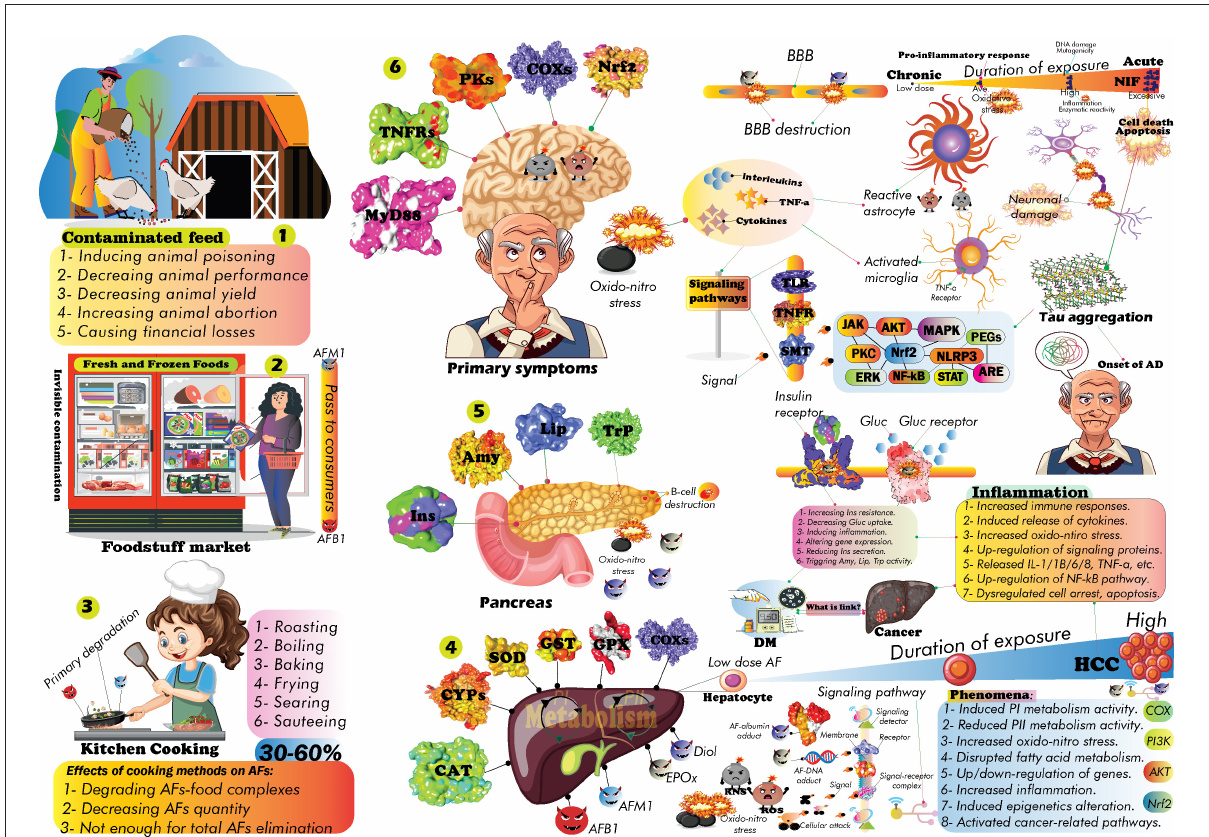
FIGURE10 The cross-links between exposure to AFs and the progression of nCDs. Contaminated feed caused damages to animal farms and produced products will pass to the consumers (Steps 1–2). Food processing methods can effectively be used to eliminate nearly 30–60% of total AFs based on the cooking method (Step 3). The rest of AFs residues in food will later affect critical organs to trigger the onset of nCDs (Steps 4–6). Duration of AFs exposure plays a critical role in the pathogenesis of AFs side effects by affecting signaling pathways, triggering inflammation and oxido-nitro